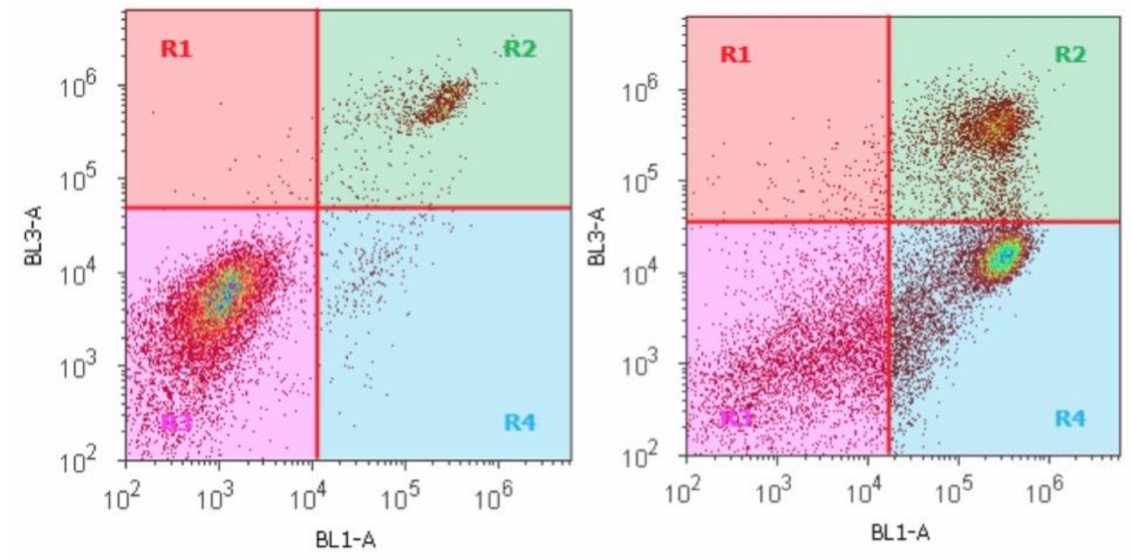
Figure 5. Annexin V/PI flow cytometry of 11 employing A375 cells (48 h of incubation, 2 × EC 50 concentration); control experiment (left), incubation with 11 (right); R1 necrotic cells, R2 late apoptotic cells, R3 viable cells, and R4 apoptotic